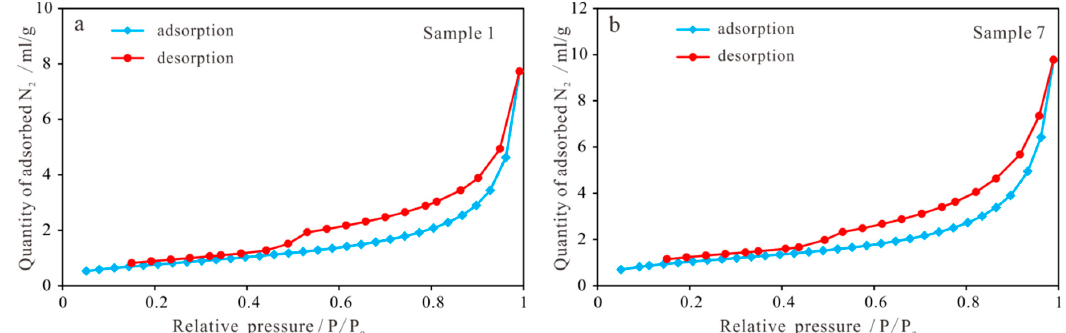
Figure 4. N 2 adsorption and desorption isotherms of two Yanchang shale samples. ( a ) N 2 adsorption and desorption isotherms of Sample 1; ( b ) N 2 adsorption and desorption isotherms of Sample 7.